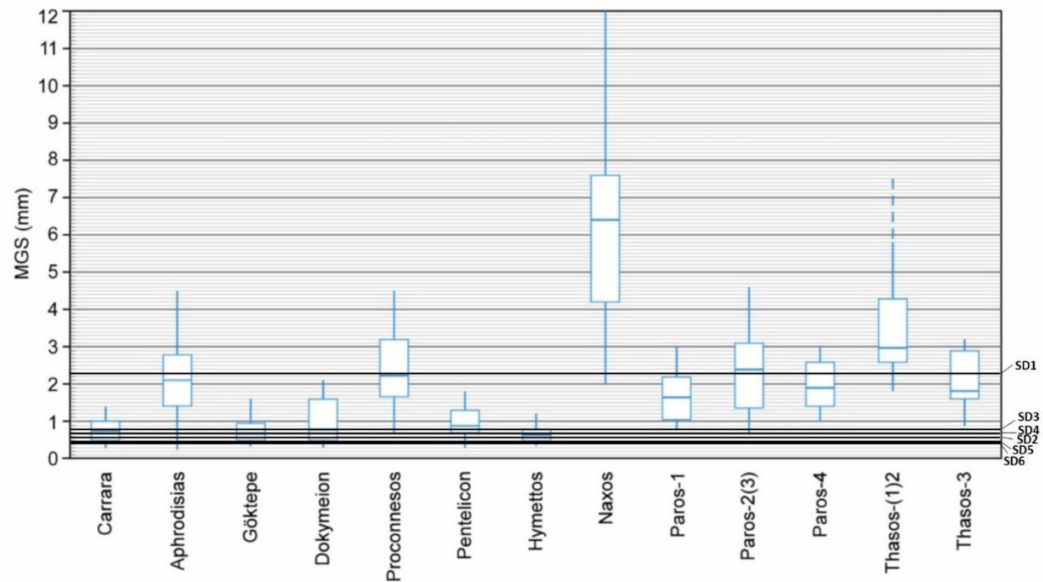
Figure 3. Maximum grain size (MGS) diagram modified from [21] related to the 10 chief white marbles used in classical times. (Notes: Dokymeion = Docimium (Latin version)/Afyon districts; Proconnesos = Marmara district; Hymettos = Hymettus